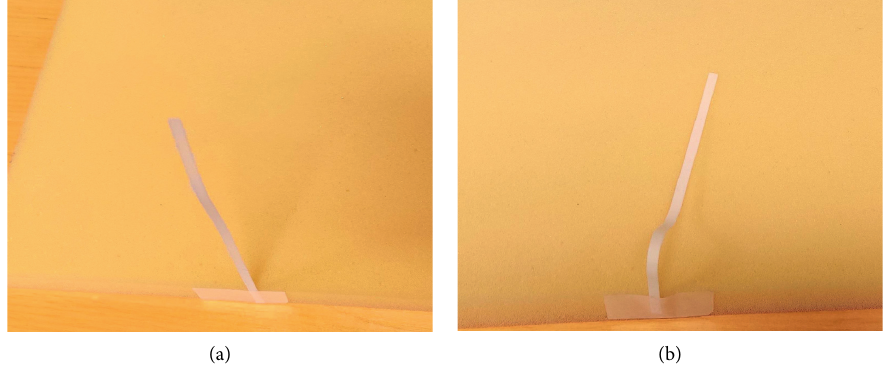
Figure 7: The developed substrate before exposure to the oven (a) and after exposure to the oven (b).